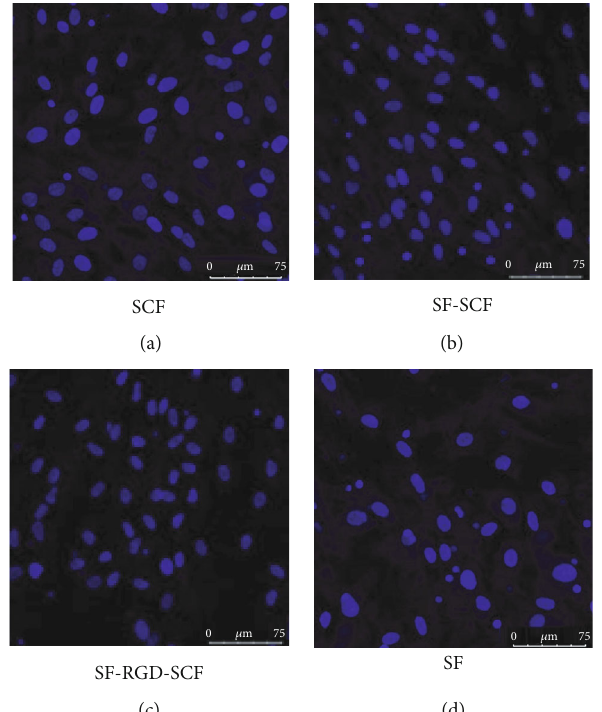
Figure 3: The nuclei of migratory cells stained with Hoechst 33258: (a) SCF group; (b) SF-SCF group; (c) SF-RGD-SCF group; (d) SF group.